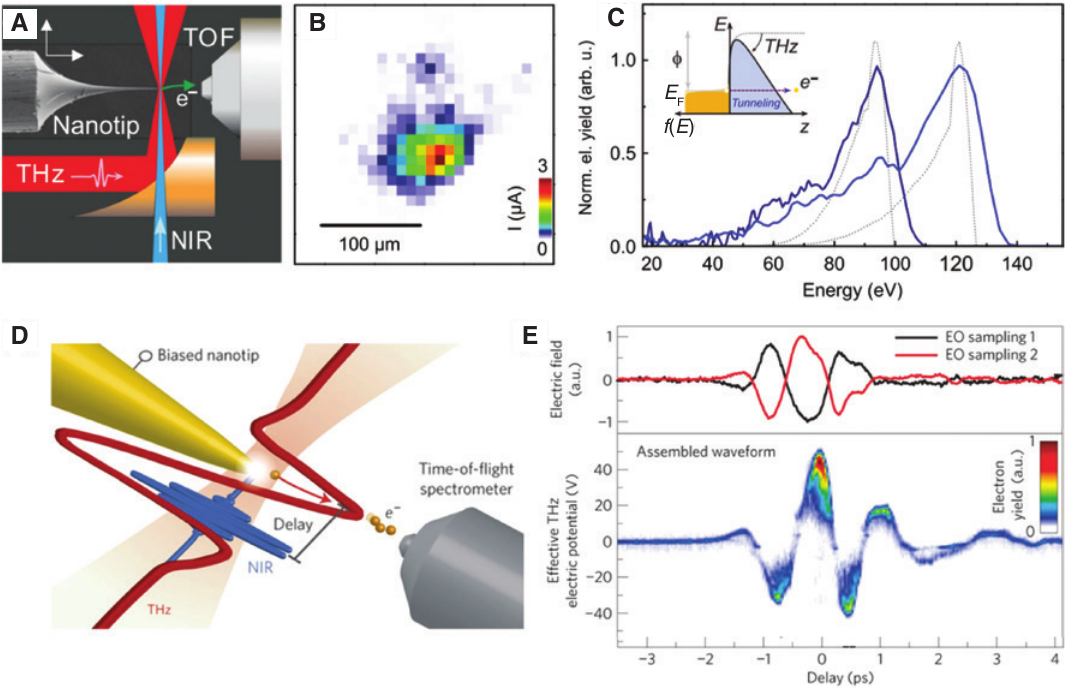
Figure 6: Nanotip-based terahertz field–driven electron emission. (A) Schematic of terahertz field–driven electron emission experiment. Incident terahertz pulse couples to a sharp tungsten tip (tip diameter of 10 nm), and the emitted electrons are detected by a TOF electron spectrometer (3-mm distance between tip apex and entrance aperture) in a high-vacuum chamber (10 −8 mbar range). (B) Field emission map measured by scanning the tip. (C) Electron energy spectra for two terahertz field strengths of 3.1 V/nm (black) and 5.3 V/nm (blue), revealing peaked energy distribution with sharp cutoffs. After tunneling process, the emitted electrons are accelerated by the strongly enhanced terahertz electric field. The dashed lines are numerical simulated results. (D) Terahertz control of photoemission in a pump–probe scheme in which near-infrared pulse induces photoelectrons, which are accelerated in the momentary terahertz potential. (E) Waveforms of terahertz electric field measured by electro-optic sampling (top) and terahertz